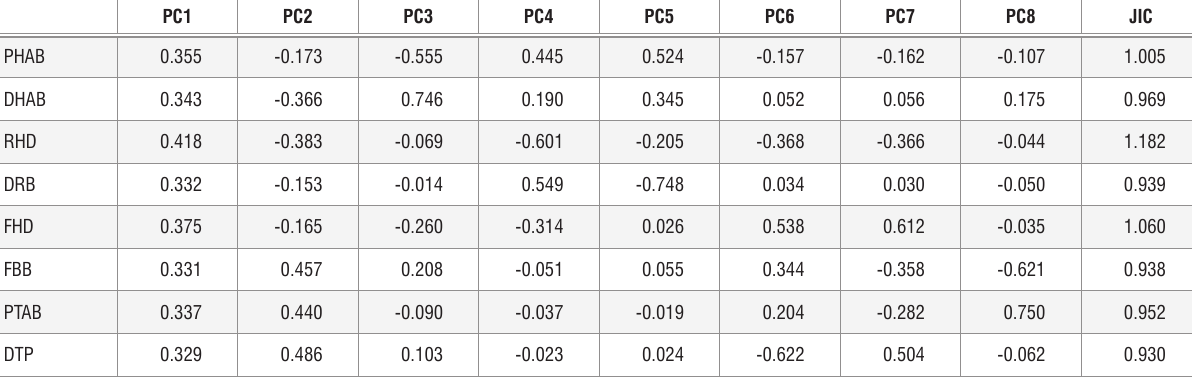
JIC, Jolicoeur multivariate allometry coefficients; PHAB, mediolateral diameter of the articular surface of the humeral head; DHAB, mediolateral diameter of the anterior surface of the distal humeral articular surface (trochlea + capitulum); RHD, maximum diameter of the radial head; DRB, maximum mediolateral diameter of the distal radial articulation; FHD, femoral head diameter (superoinferior or anteroposterior); FBB, maximum mediolateral diameter of the distal femur; PTAB, maximum mediolateral diameter of the tibial articular plateau; DTP, the square root of the product of the maximal mediolateral diameter (including the medial malleolus) and the maximum anteroposterior diameter of the distal tibia.